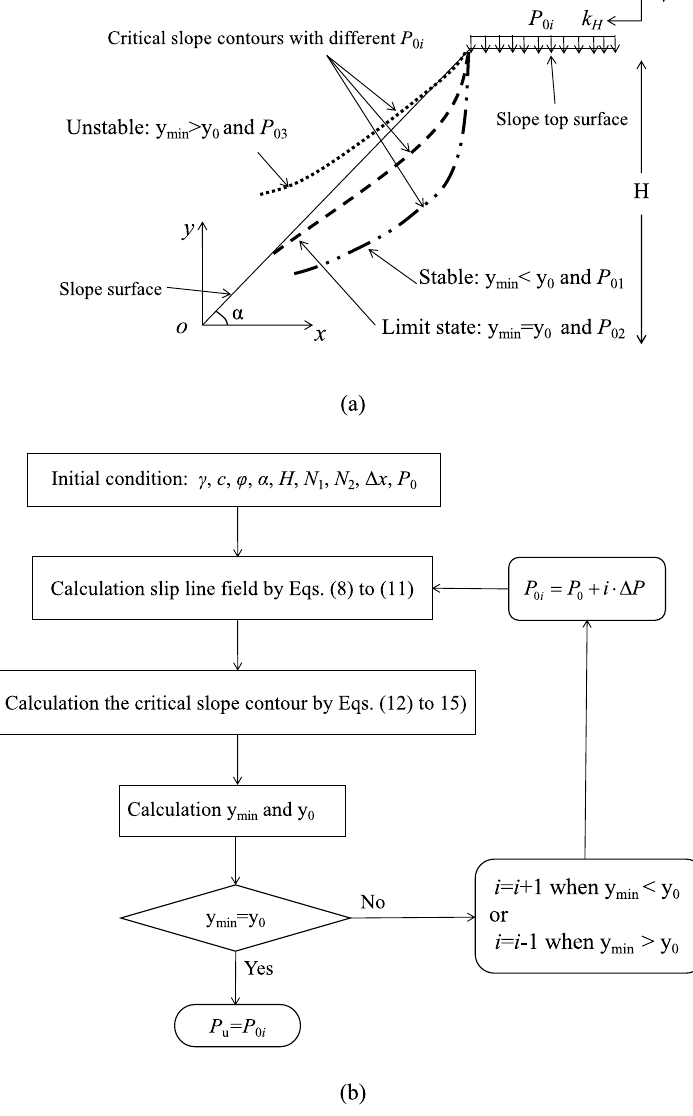
Figure 3. The proposed method: ( a ) failure mechanism; ( b ) calculation flow